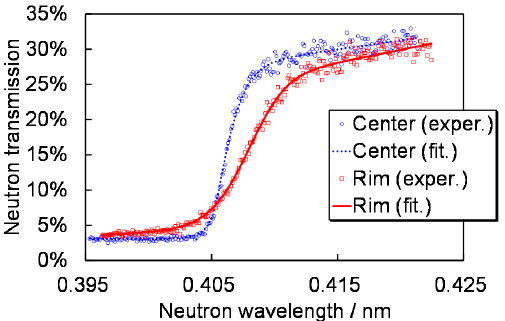
Figure 12. {110} Bragg-edge of the unquenched center (ferrite) zone and the quenched rim (martensite)